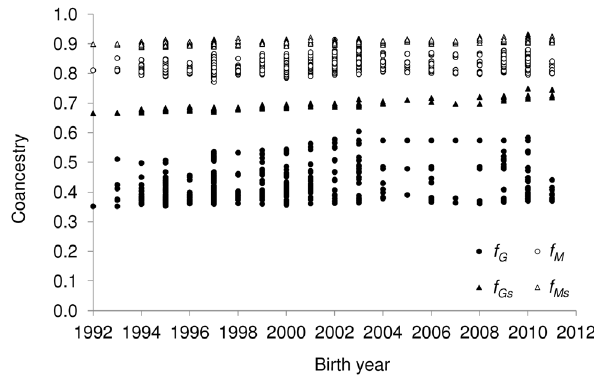
Results were obtained using the 219 Guadyerbas animals. a Rate of coancestry ( D f ( y ) ) and inbreeding ( D F ( y ) ) per year. b Rate of coancestry ( D f ) and inbreeding ( D F ) per generation. c Effective population size calculated from the rate of coancestry ( N e_f ) or the rate of inbreeding inbreeding ( N e_F ) per generation.